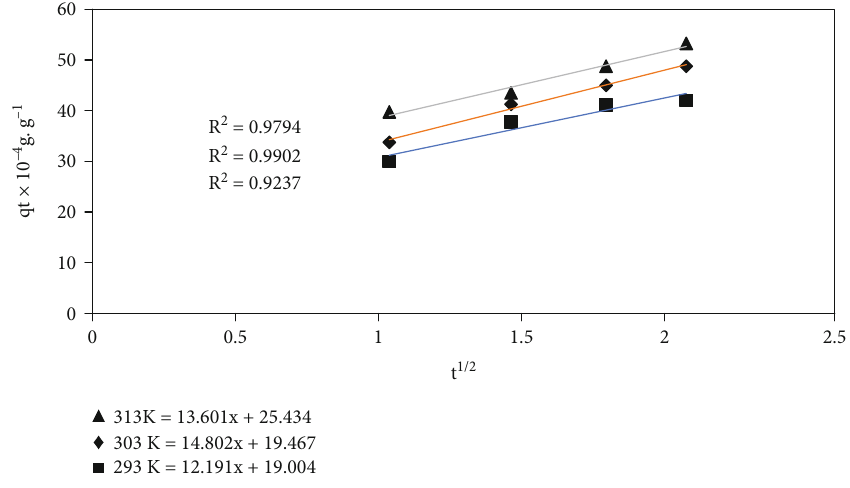
Figure 11: Intraparticle di ff usion plot. Table 4: Constant of intraparticle di ff usion. Temperature 293K